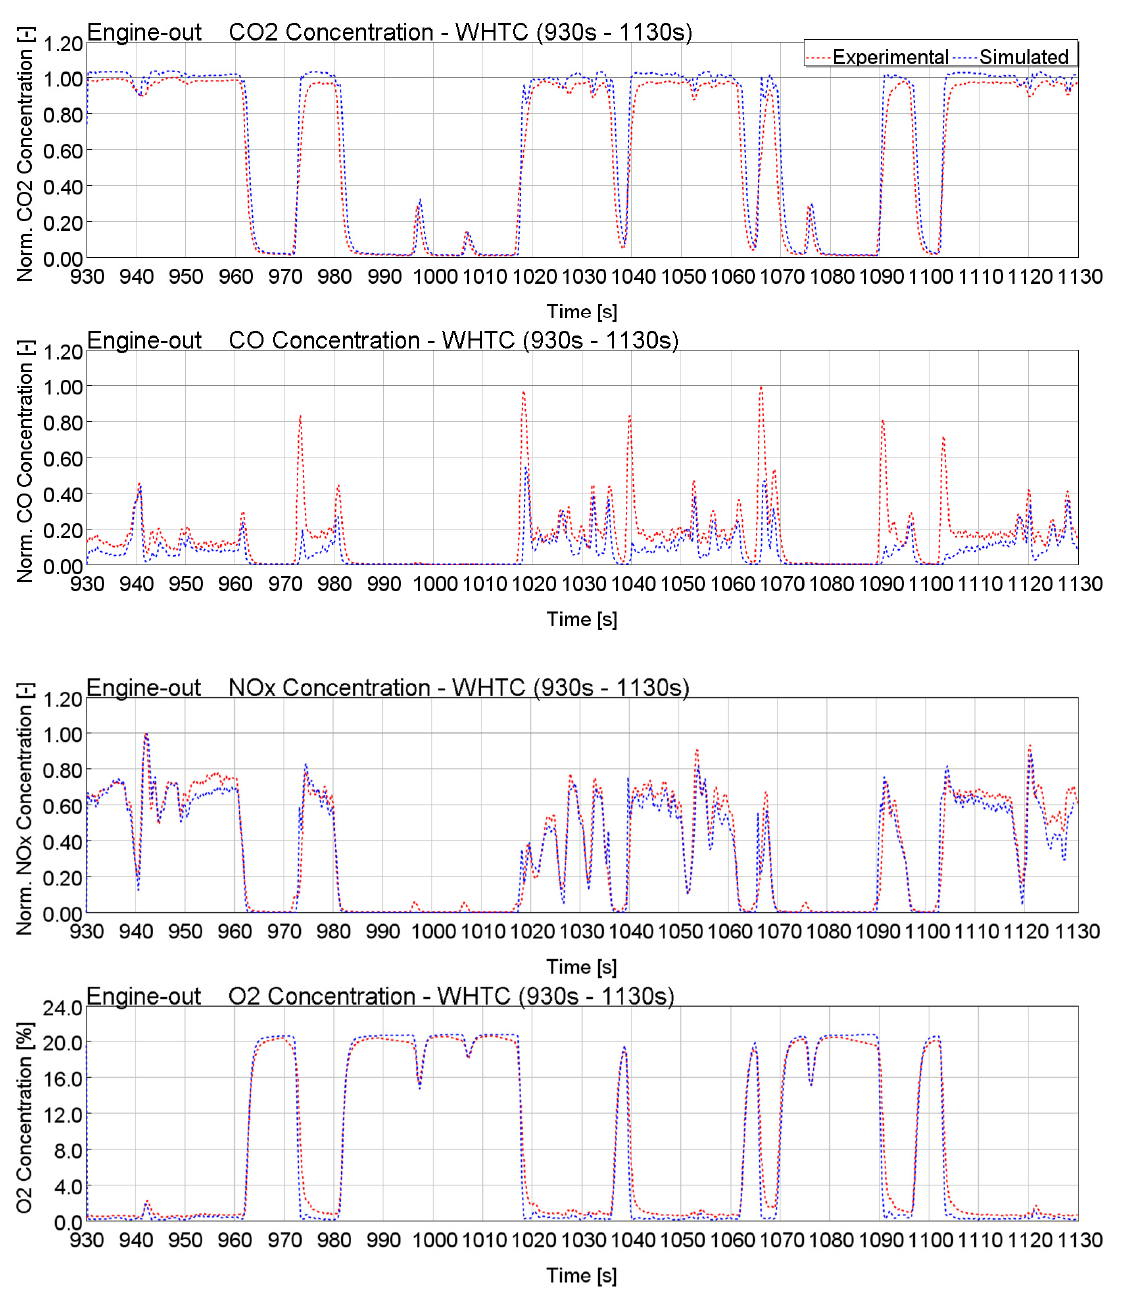
Figure 14. NO, CO, CO 2 and O 2 engine-out concentrations; comparison between predicted and experimental data during a characteristic timeframe of the WHTC.